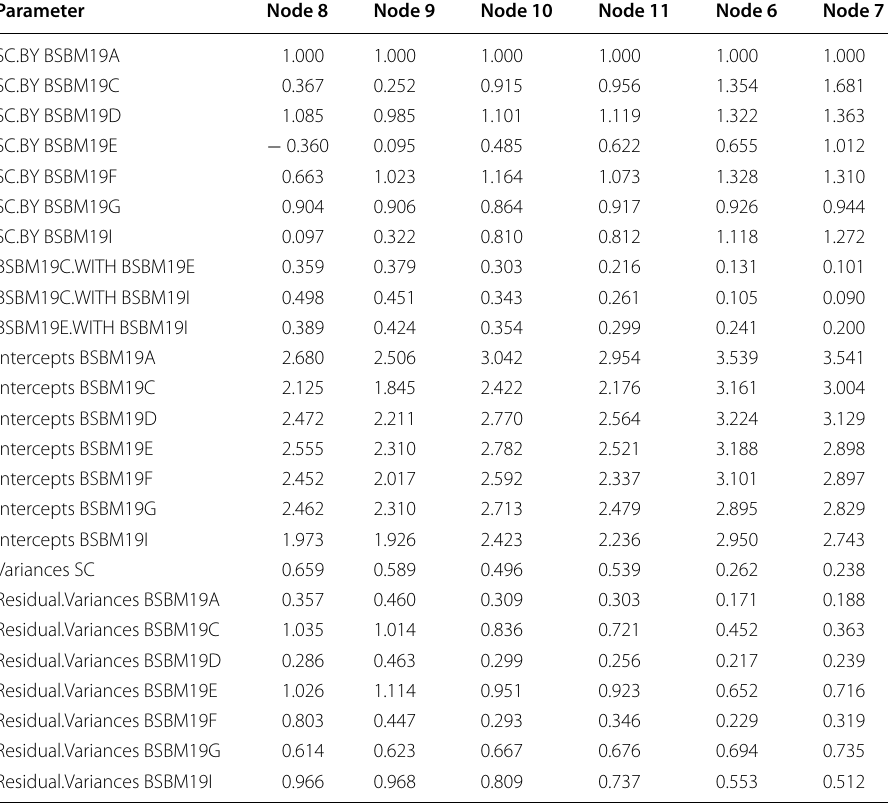
Table 2 Parameter estimates for terminal nodes from Mplus tree with complexity parameter of